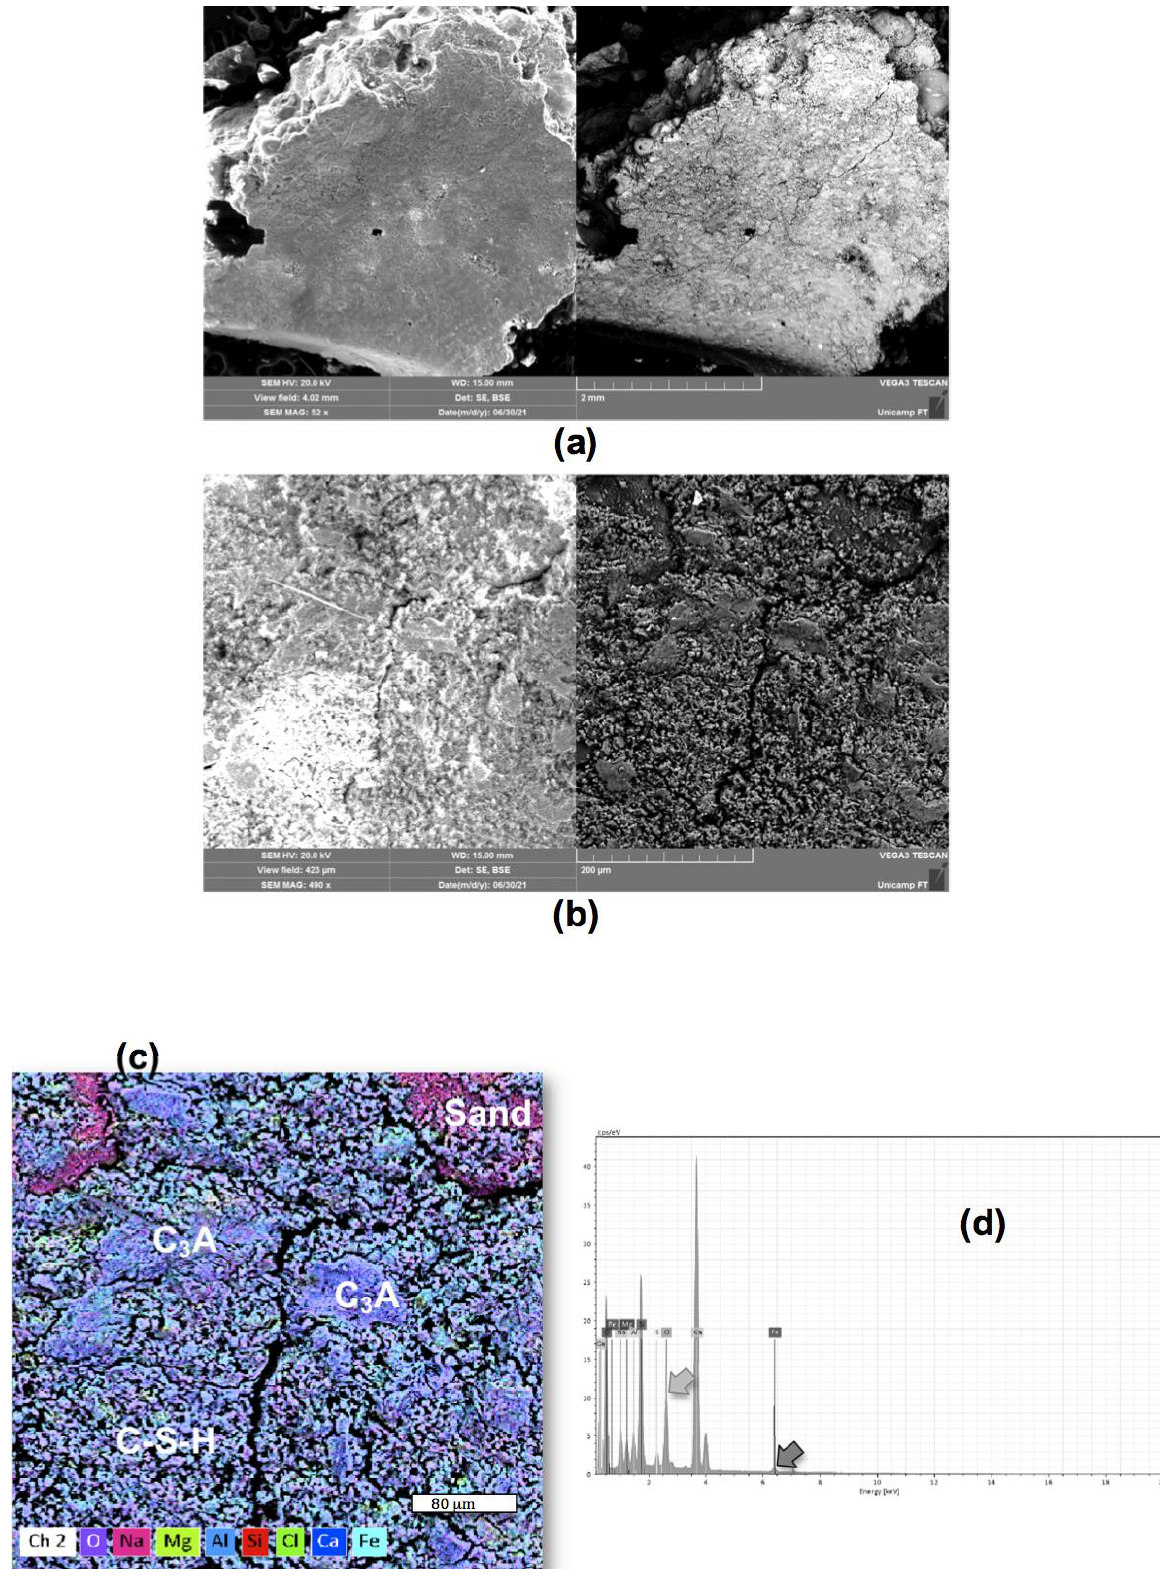
Figure 15. ( a , b ) typical SEM micrographs of the CEM sample and ( c , d ) elemental map and EDX diagram of the CC (reference/control) sample, respectively.